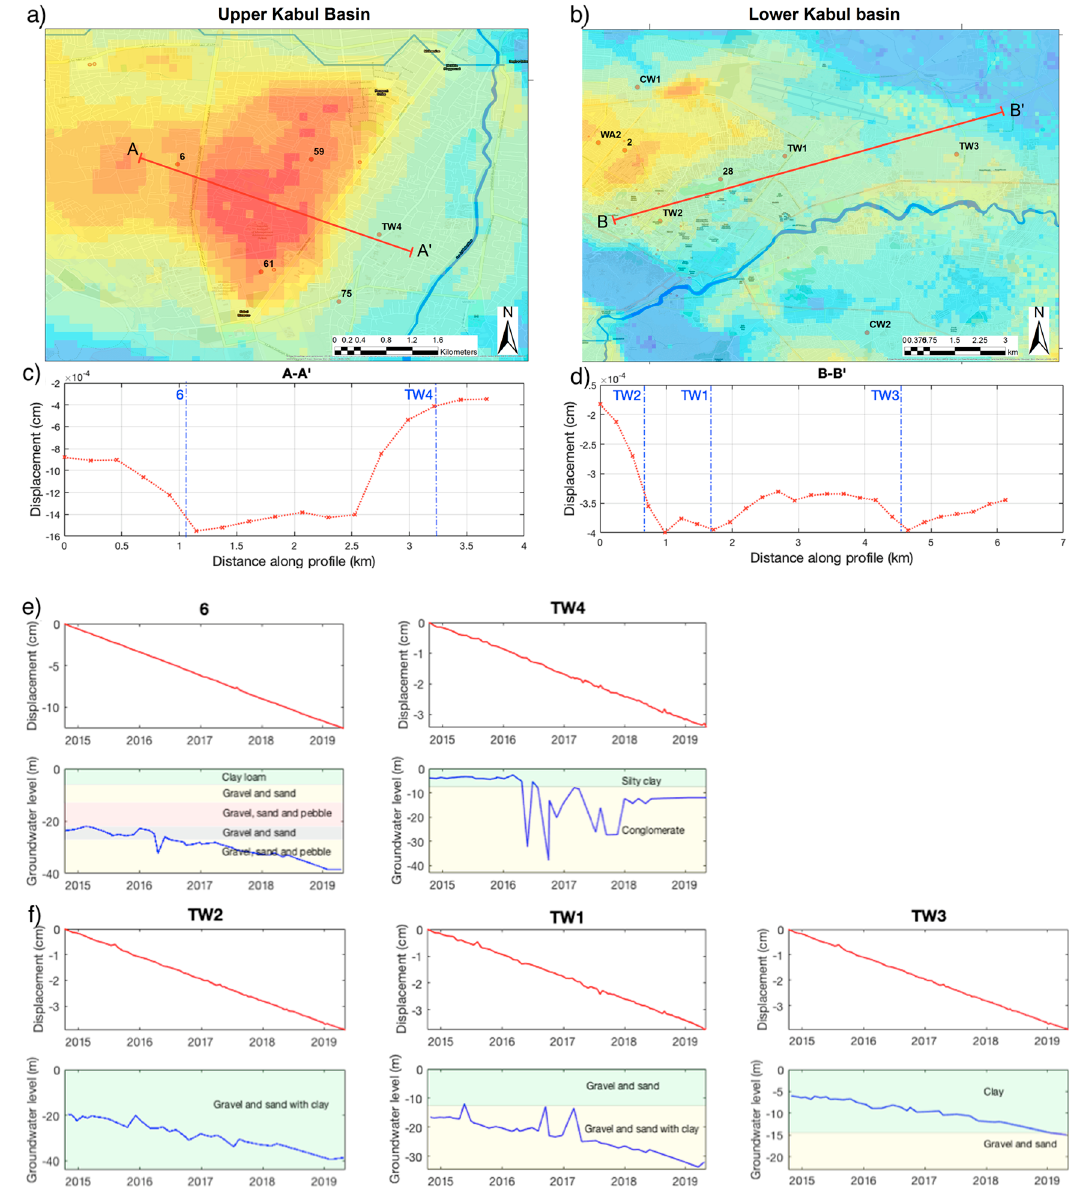
Figure 8. ( a ) Location of cross-sections used in the study selected in Upper and ( b ) Lower Kabul basins; ( c , d ) subsidence profiles extracted along each cross-section, with the location of the corresponding SWL wells denoted with blue dashed line; ( e , f ) InSAR-derived subsidence time-series is plotted along with SWL variations and relevant stratigraphic column at each well.